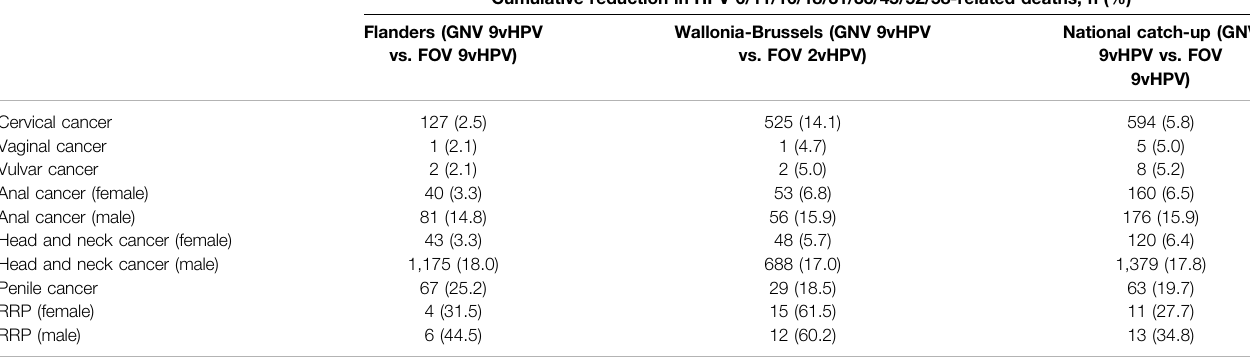
TABLE 6 | Cumulative reduction in HPV 6/11/16/18/31/33/45/52/58-related deaths over 100 years with 9vHPV vaccination in females and males compared with female- only